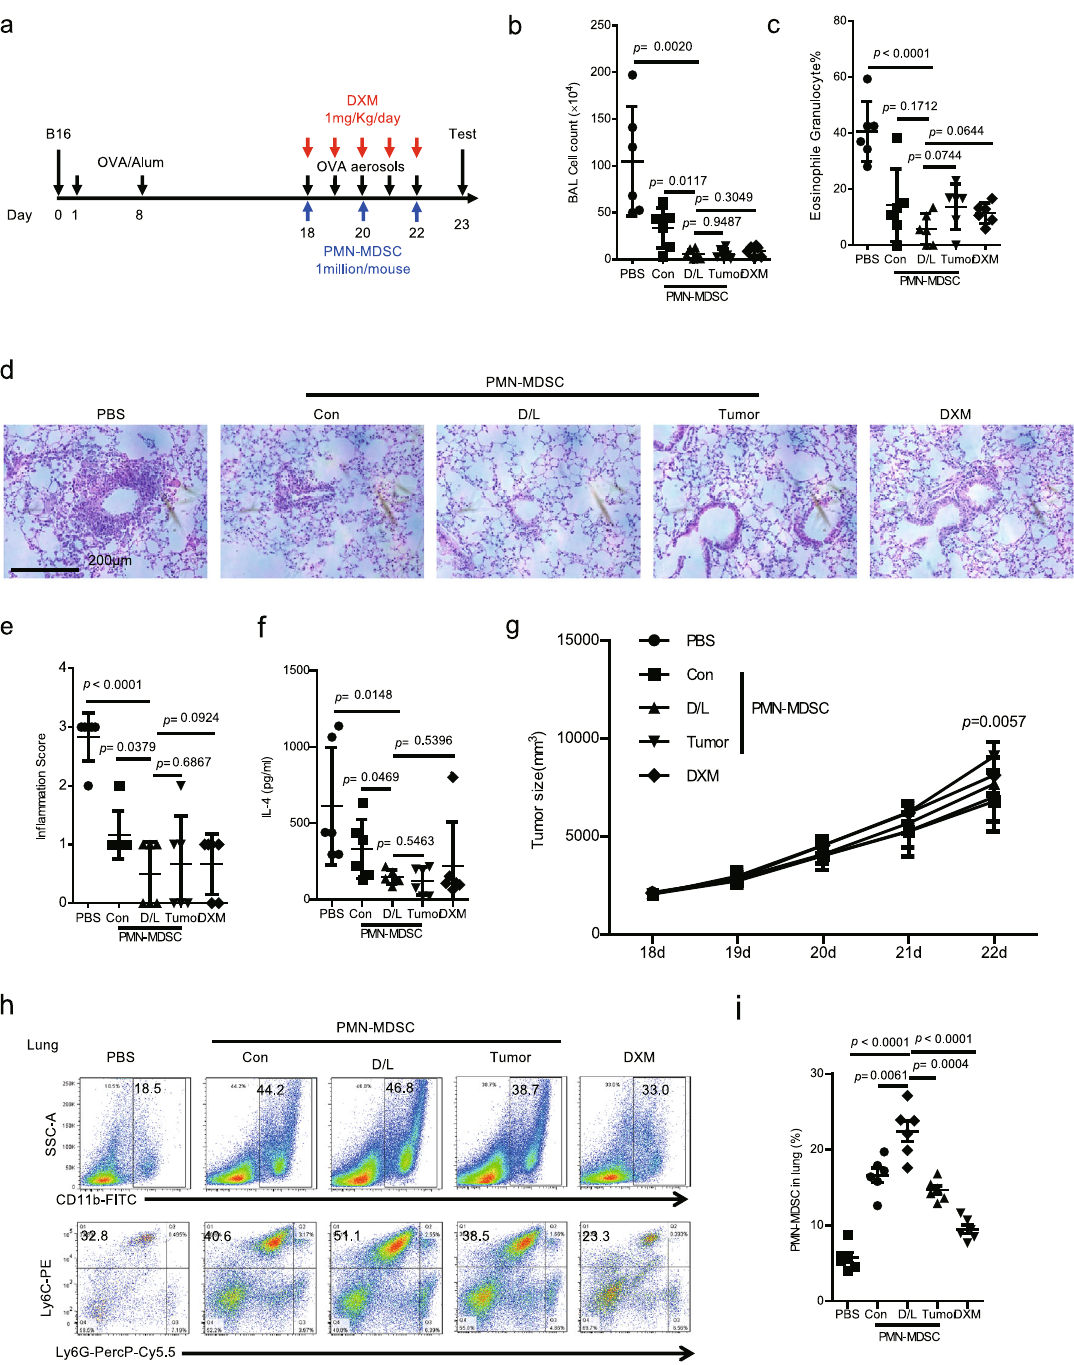
Fig. 7 Transfer of DXM- and lactoferrin-induced PMN-MDSC relieved allergic pneumonitis without promoting tumor development. a Diagram of the experimental design. Adult mice were intraperitoneally sensitized with 5 μ g/g OVA emulsi fi ed in 200 μ g/g of aluminum hydroxide on days 1 and 8 after tumor cell implantation, followed by intranasal challenge with OVA (5 μ g/ μ l of PBS) daily on day 18 through 22. One day after the last challenge, the mice were sacri fi ced, and the lung in fl ammation was examined. For PMN-MDSC transfer experiments, 1 × 10 6 cells of Con PMN-MDSC, DXM/lactoferrin (D/L) PMN-MDSC, tumor PMN-MDSC, or vehicle control (PBS) were administered i.v. before the fi rst challenge every other day three times. DXM was administered at 1 mg/kg/day followed by every challenge in the indicated group. b Total cell counts in the bronchoalveolar lavage fl uid (BALF). c Eosinophil granulocyte percentage in BALF cells. d Representative images of hematoxylin and eosin-stained sections of the lungs and e Histopathological scores. f IL-4 level in BALF by ELISA. g Tumor growth. h Typical example of fl ow cytometric analysis and i statistical analysis of PMN-MDSCs in the lungs ( n = 6 biologically independent animals). Error bars displayed the mean and standard